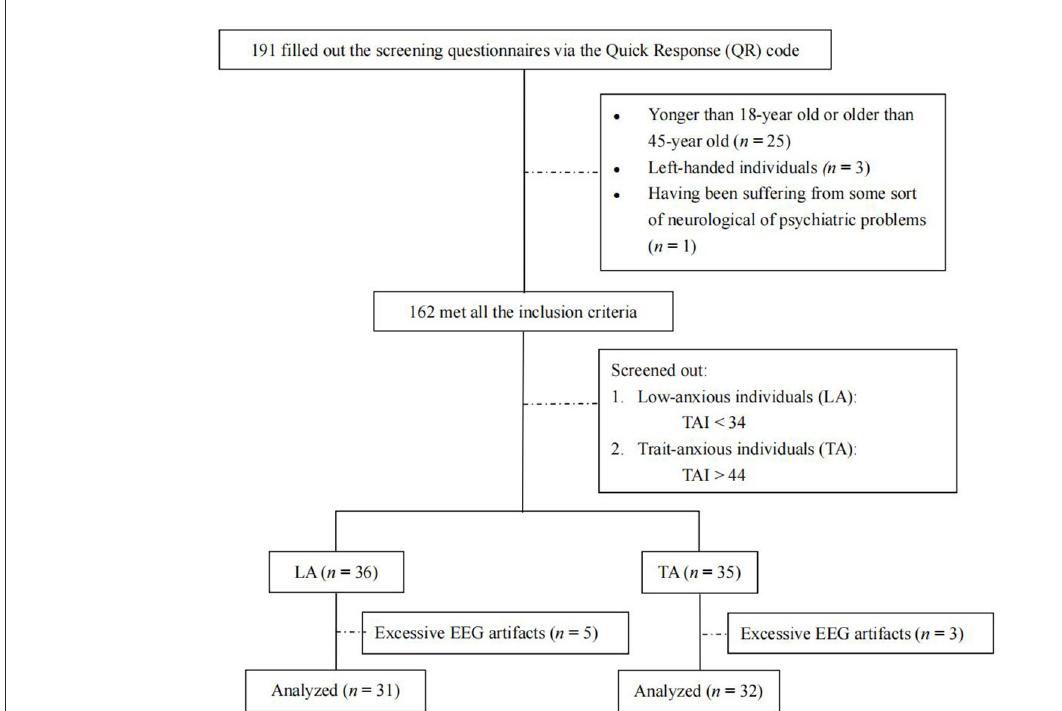
FIGURE1 Flow of participants.